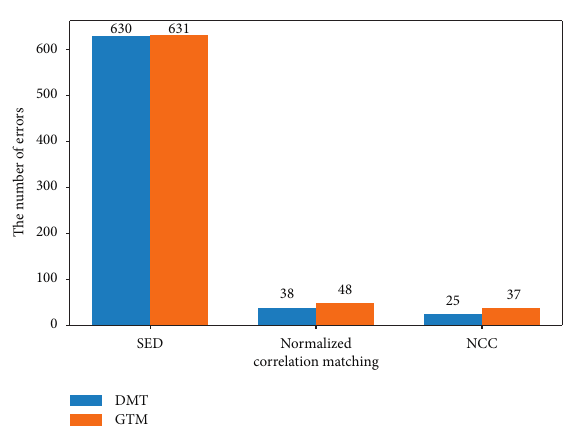
Figure 11: Comparison of the number of wrong positioning between DTM and GTM.